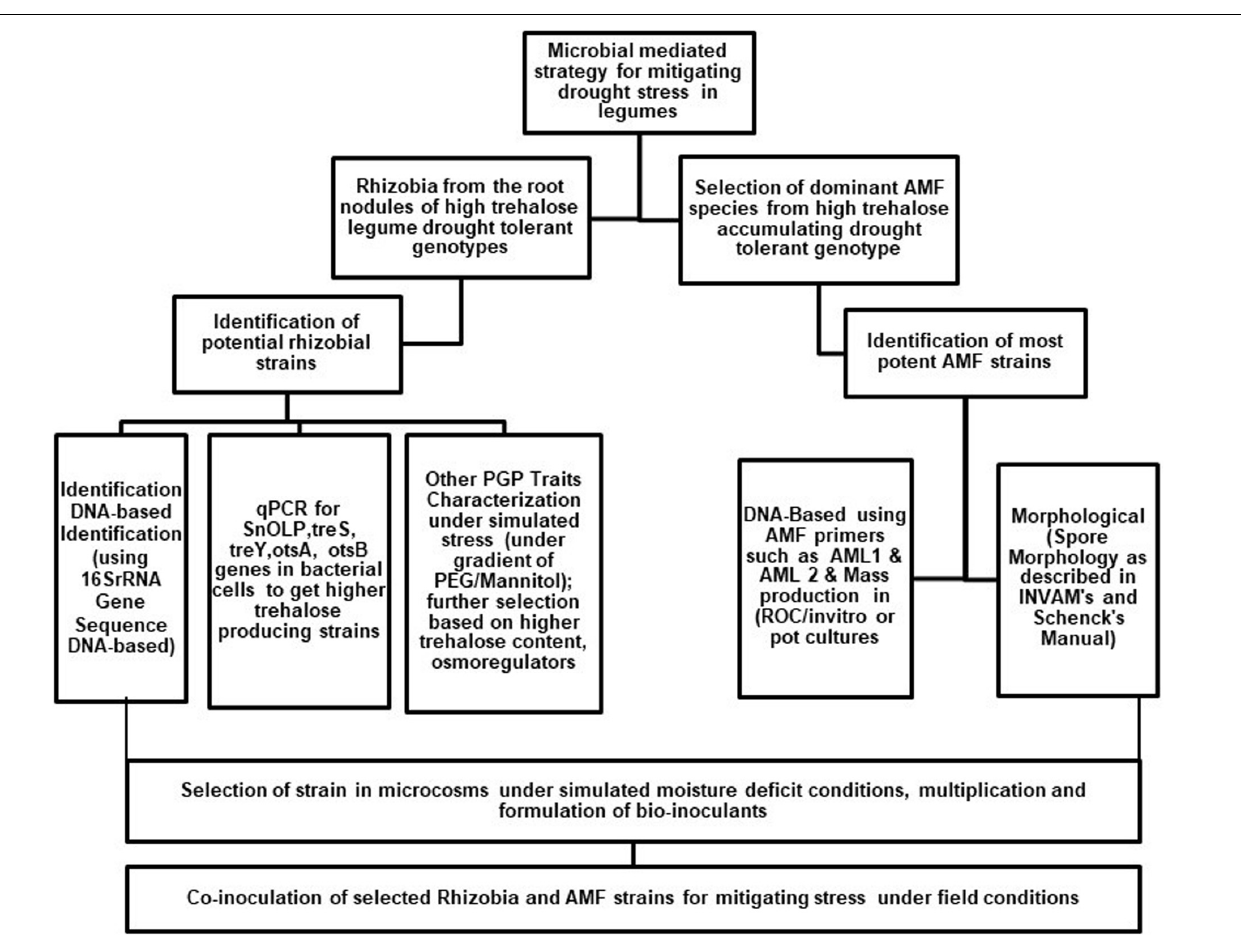
FIGURE 2 | Diagrammatical representation for developing agro-microbial strategy utilizing arbuscular mycorrhizal fungi and rhizobia for mitigating drought stress in